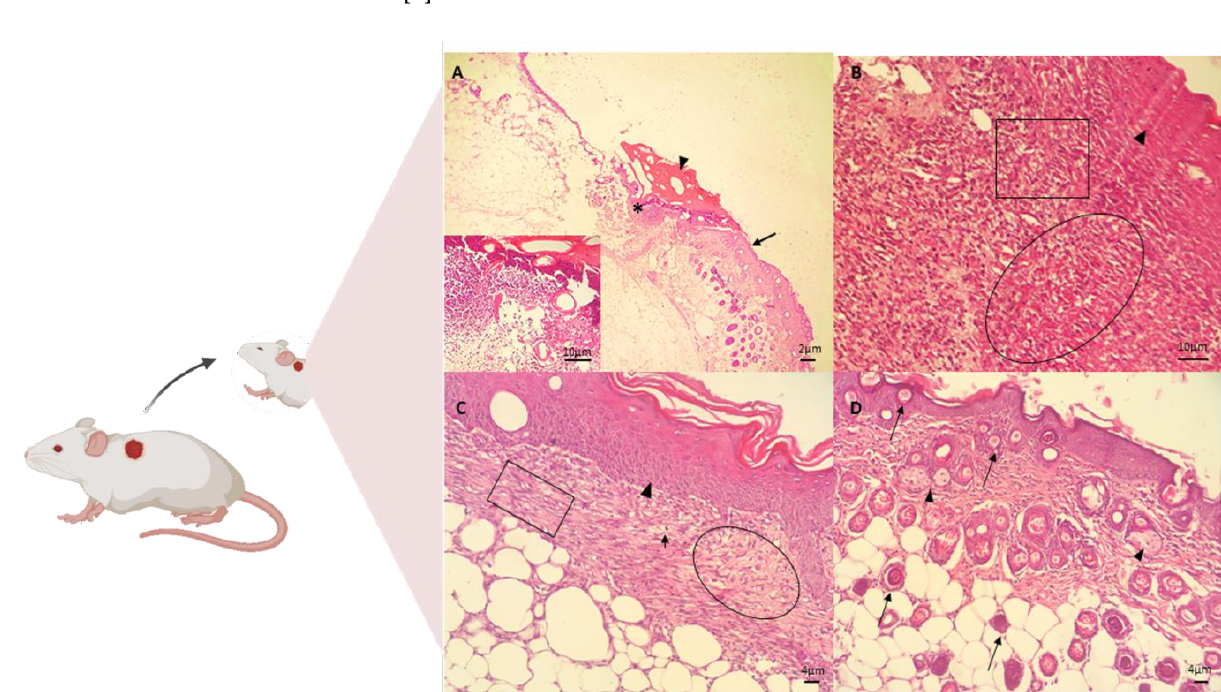
Figure 5. Photomicrographs of skin wounds on the ( A ) 3rd, ( B ) 7th, ( C ) 14th, and ( D ) 21st day of treatment for the group treated with chicha gum/chitosan/ Mauritia flexuosa oil gel (CGCHO). H.E. stain. (Scale bar: 2 µm, 4 µm, and 10 µm). ( A ) Skin ulcer (*) with the epidermis on the right edge (arrows), fibrin clot (arrowheads), and inflammatory infiltrate of polymorphonuclear cells in the dermis (detail). ( B ) Continuing reepithelialization of the epidermis (arrowhead), presence of newly formed vessels in granulation tissue in the dermis (circle), and macrophages and new fibroblasts (square). ( C ) Epidermal reepithelialization (arrowheads) and extensive granulation tissue formation (circle), with neoformed vessels (arrows), and collagen fibers(square). ( D ) Presence of hairs follicle (bulbus-arrows) and sebaceous glands (arrowheads).